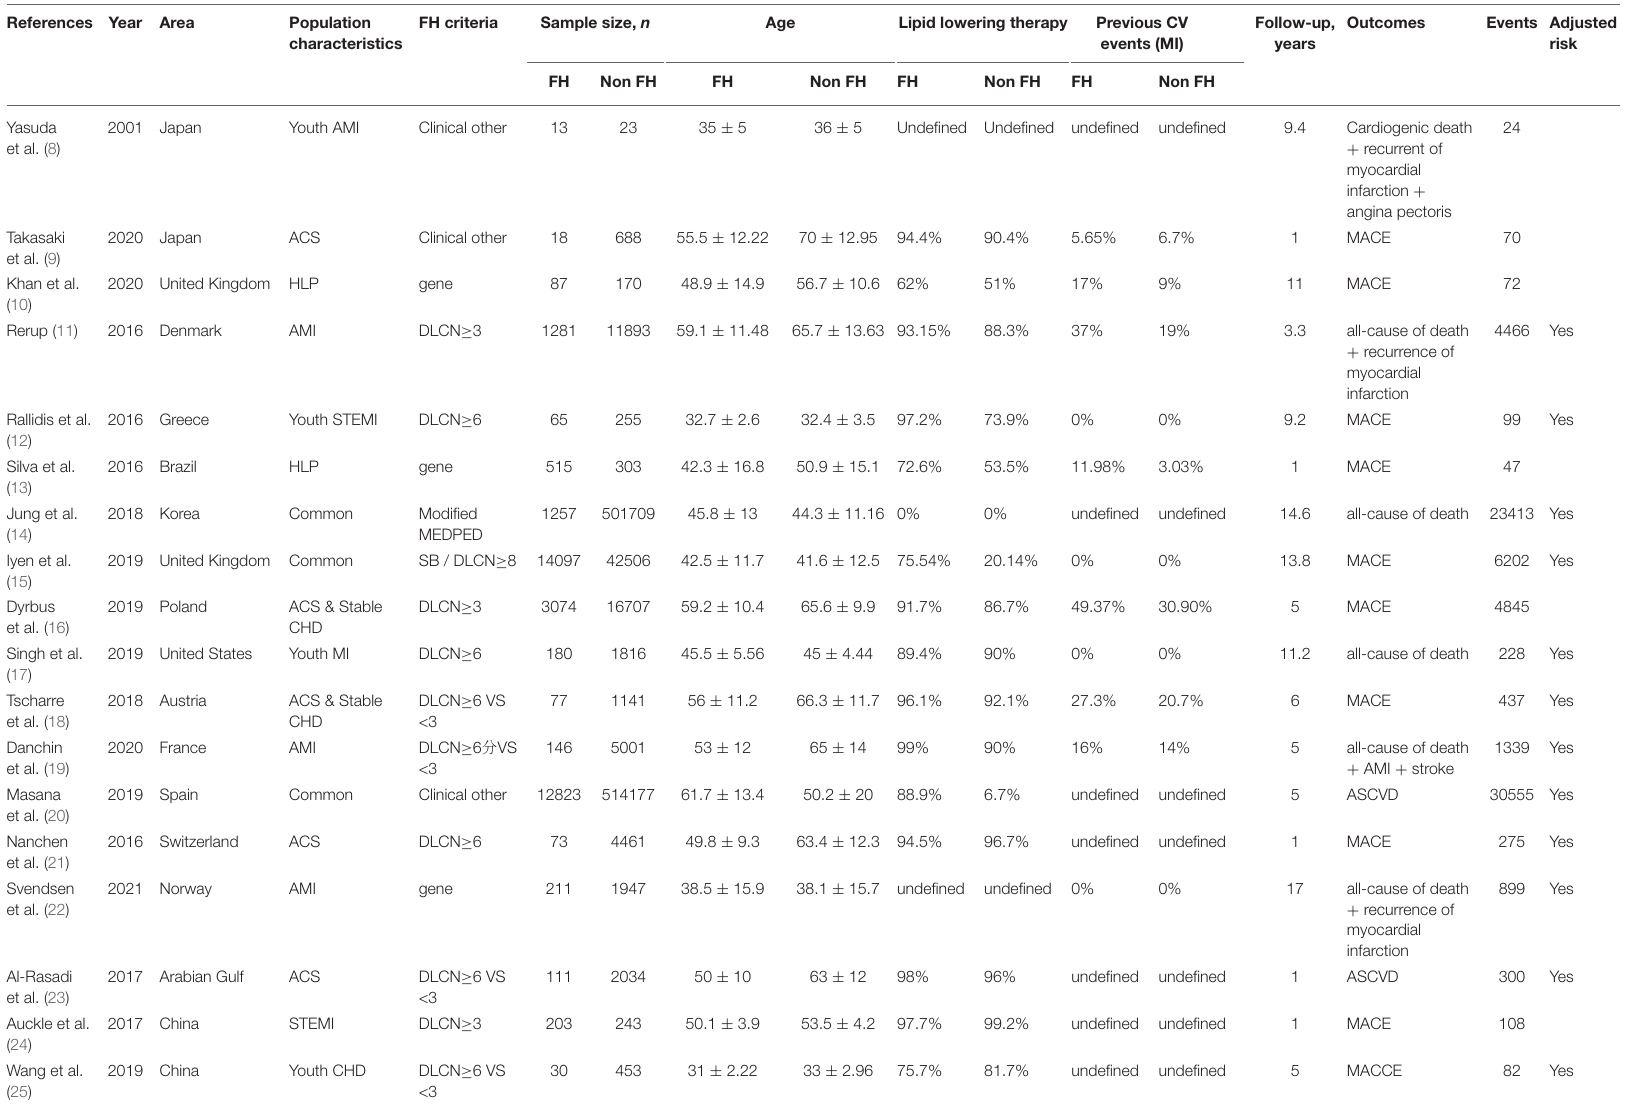
TABLE 1 | Characteristics of the included